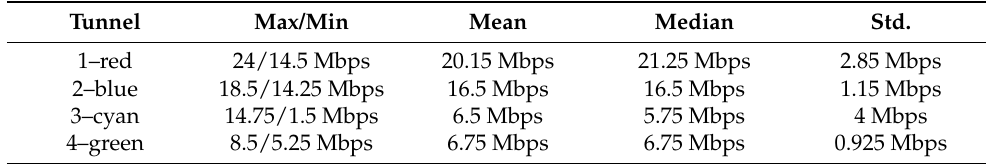
Table 1. Statistical parameters of the considered 4 virtual tunnels.